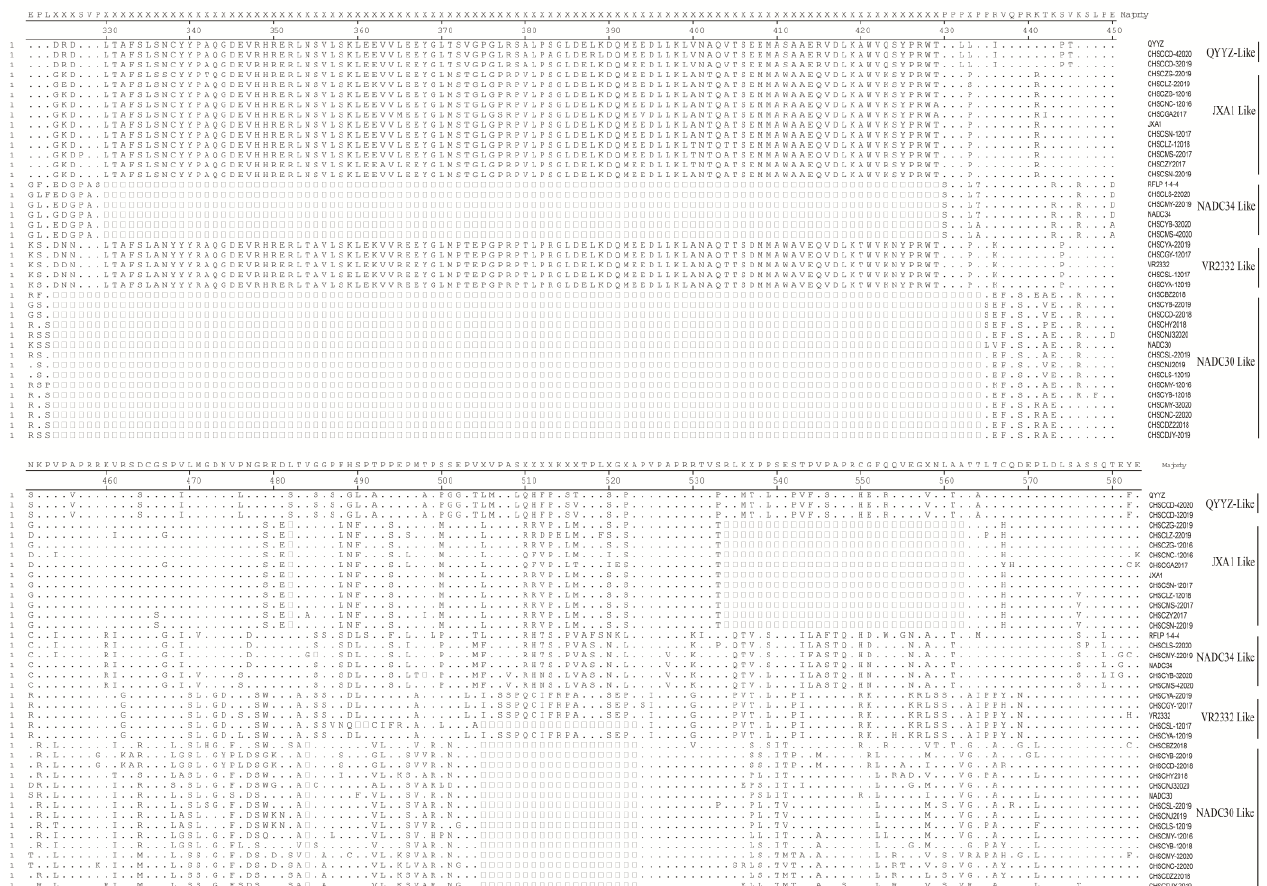
Figure 5. Amino acid sequence alignment of Nsp2 protein.